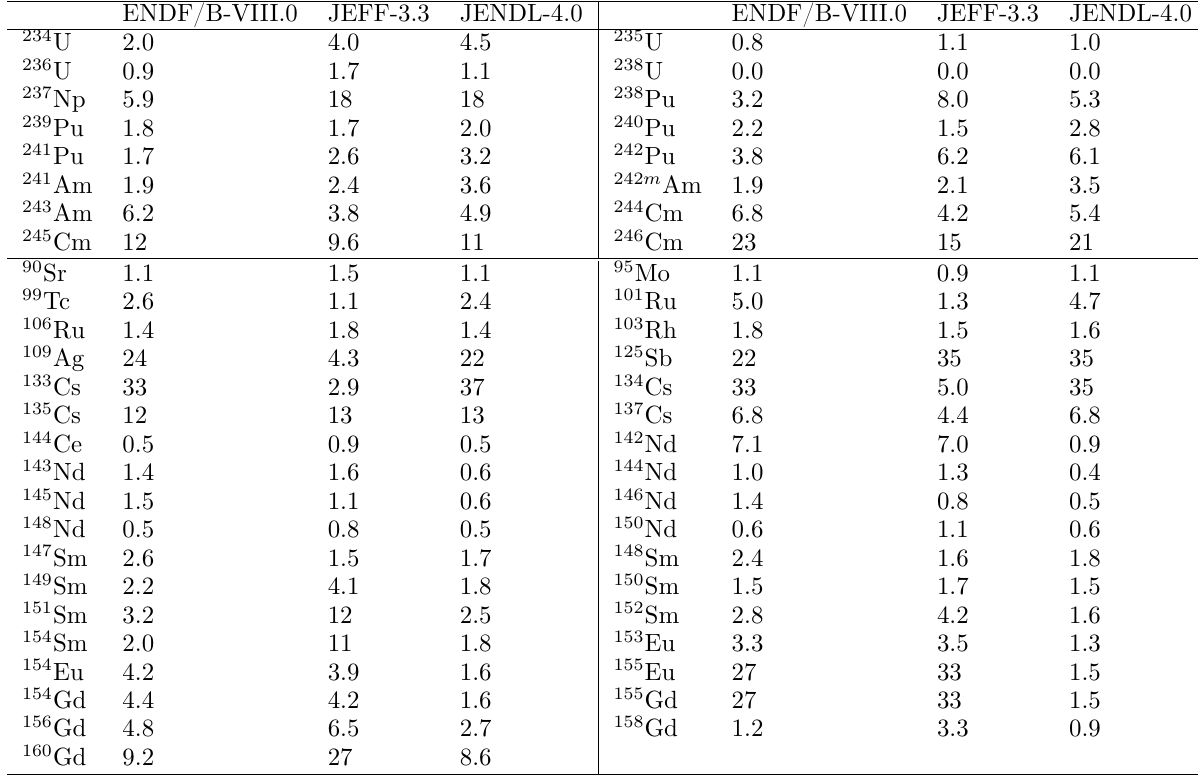
Table B.7. Comparison in % between the impact of the nuclear data libraries for the BM1-P sample with the assembly model, based on the CASMO5 v2.03 calculations. Value are at the time of measurement.